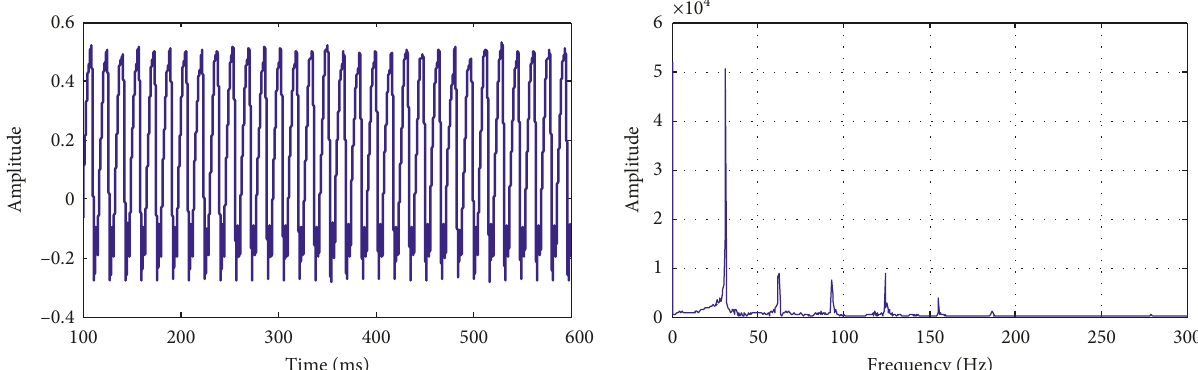
Figure 5: Vertical vibration amplitude signals and its frequency diagram on left bearing.